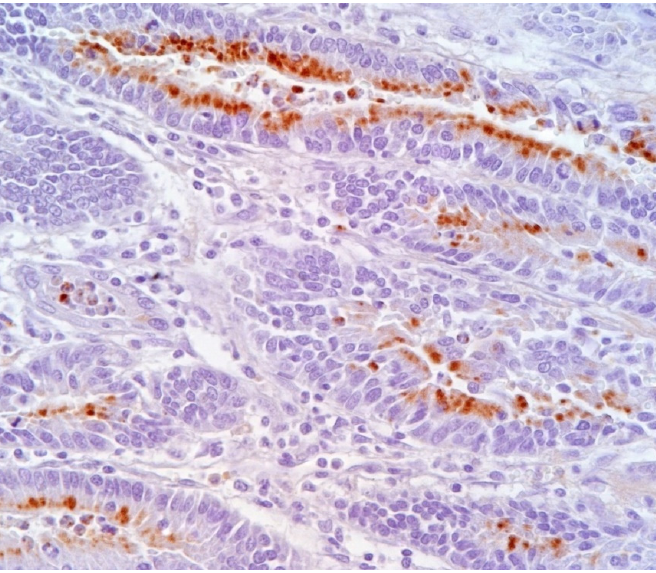
Figure 24. Ileum of pig affected by PE. L. intracellularis organisms in the apical cytoplasm of hyper ‐ plastic epithelium lining intestinal glands (IHC, 40×) (Courtesy of Prof. G.